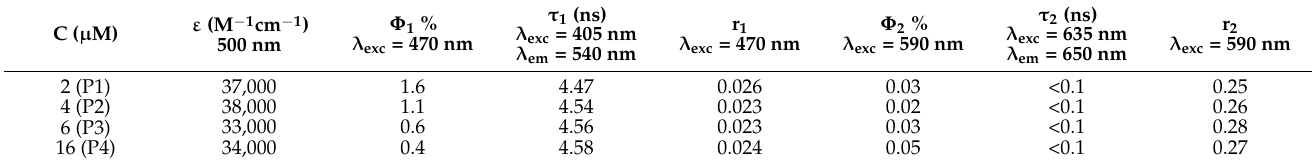
Table 1. Photophysical properties of P in water (pH = 7) at different concentrations.